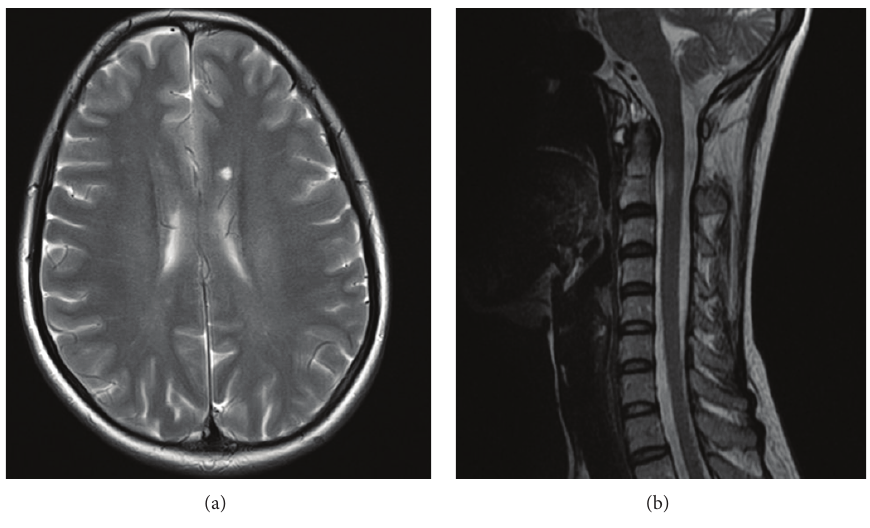
F 1: Brain MRI (a) and cervical spine MRI